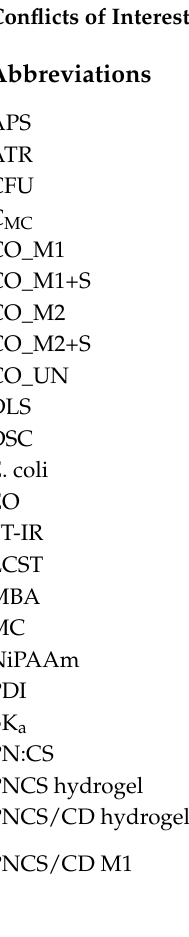
Table S1: Essential oil chromatography sheet records provided by the producer of the used EO (Florihana Distillerie, Caussols, France), Figure S1: Zone of inhibition of disc impregnated with (a)–DMSO, and discs impregnated with (b)–1%, (c)–2%, (d)–3%, (e)–4% and (f)–5% concentration of savory EO in